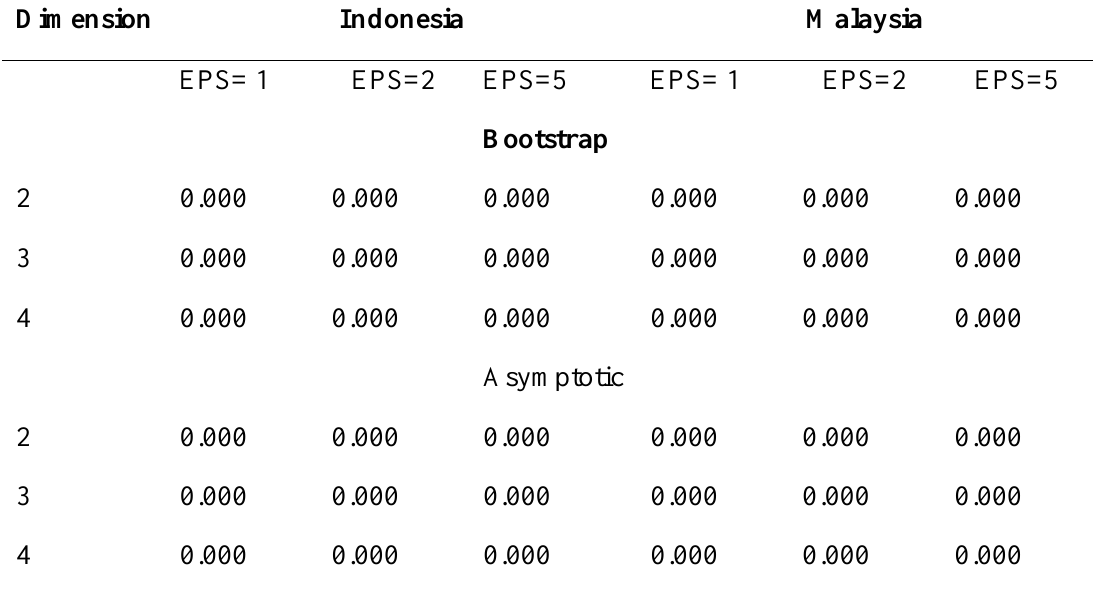
Table 5.B. BDS Test on AR ( p )